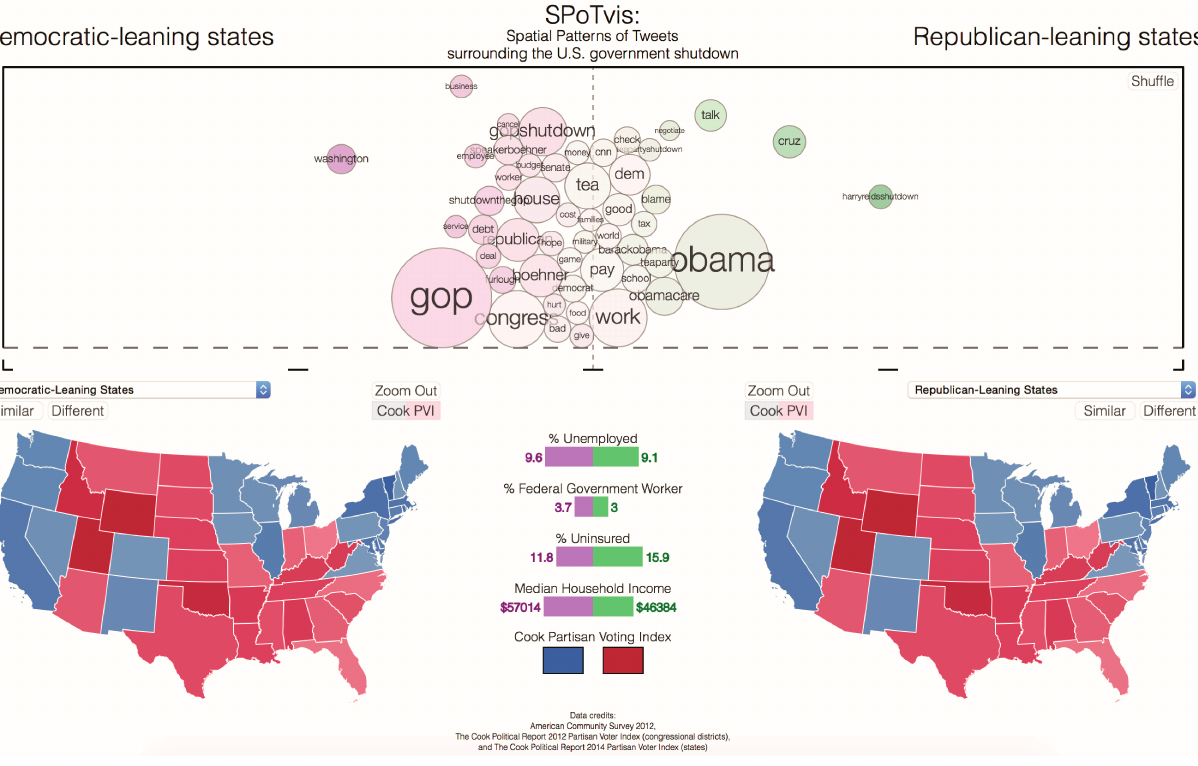
Figure 6. Initial view of SPoTvis comparing Democratic-leaning states with Republican-leaning